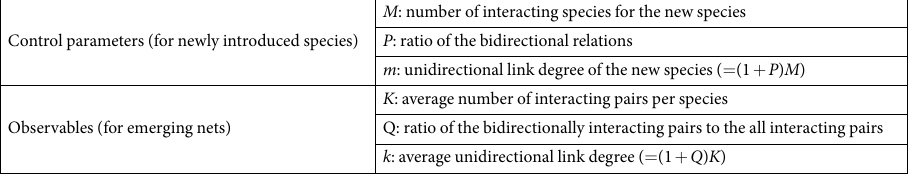
Table 2. Parameters and observables of the present